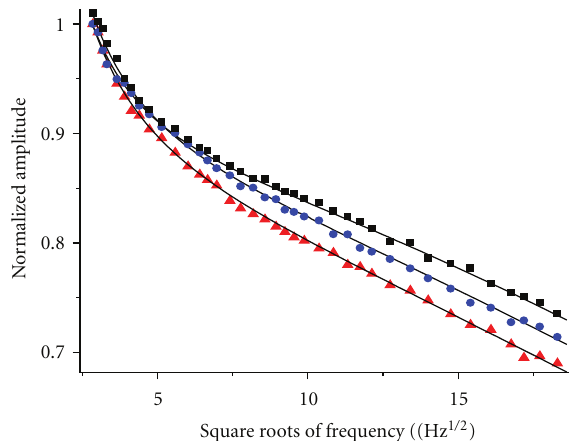
Figure 3: Amplitude of the experimental photothermal signal versus F 1 / 2 for the three In 2 S 3 samples: S1 (squares), S2 (circles), and S3 (triangles), fitted with theoretical curves (line). Figure 1: Experimental setup.